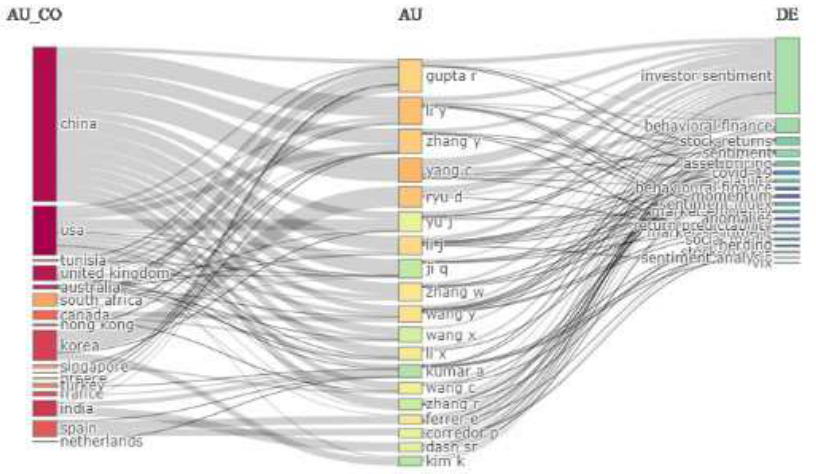
Figure 4. Three-field plot of author’s country, authors, and